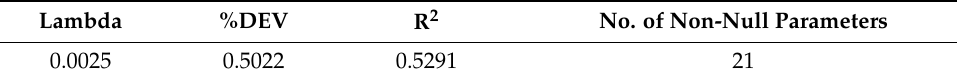
Table 6. Values of the LASSO regression models developed with the selected